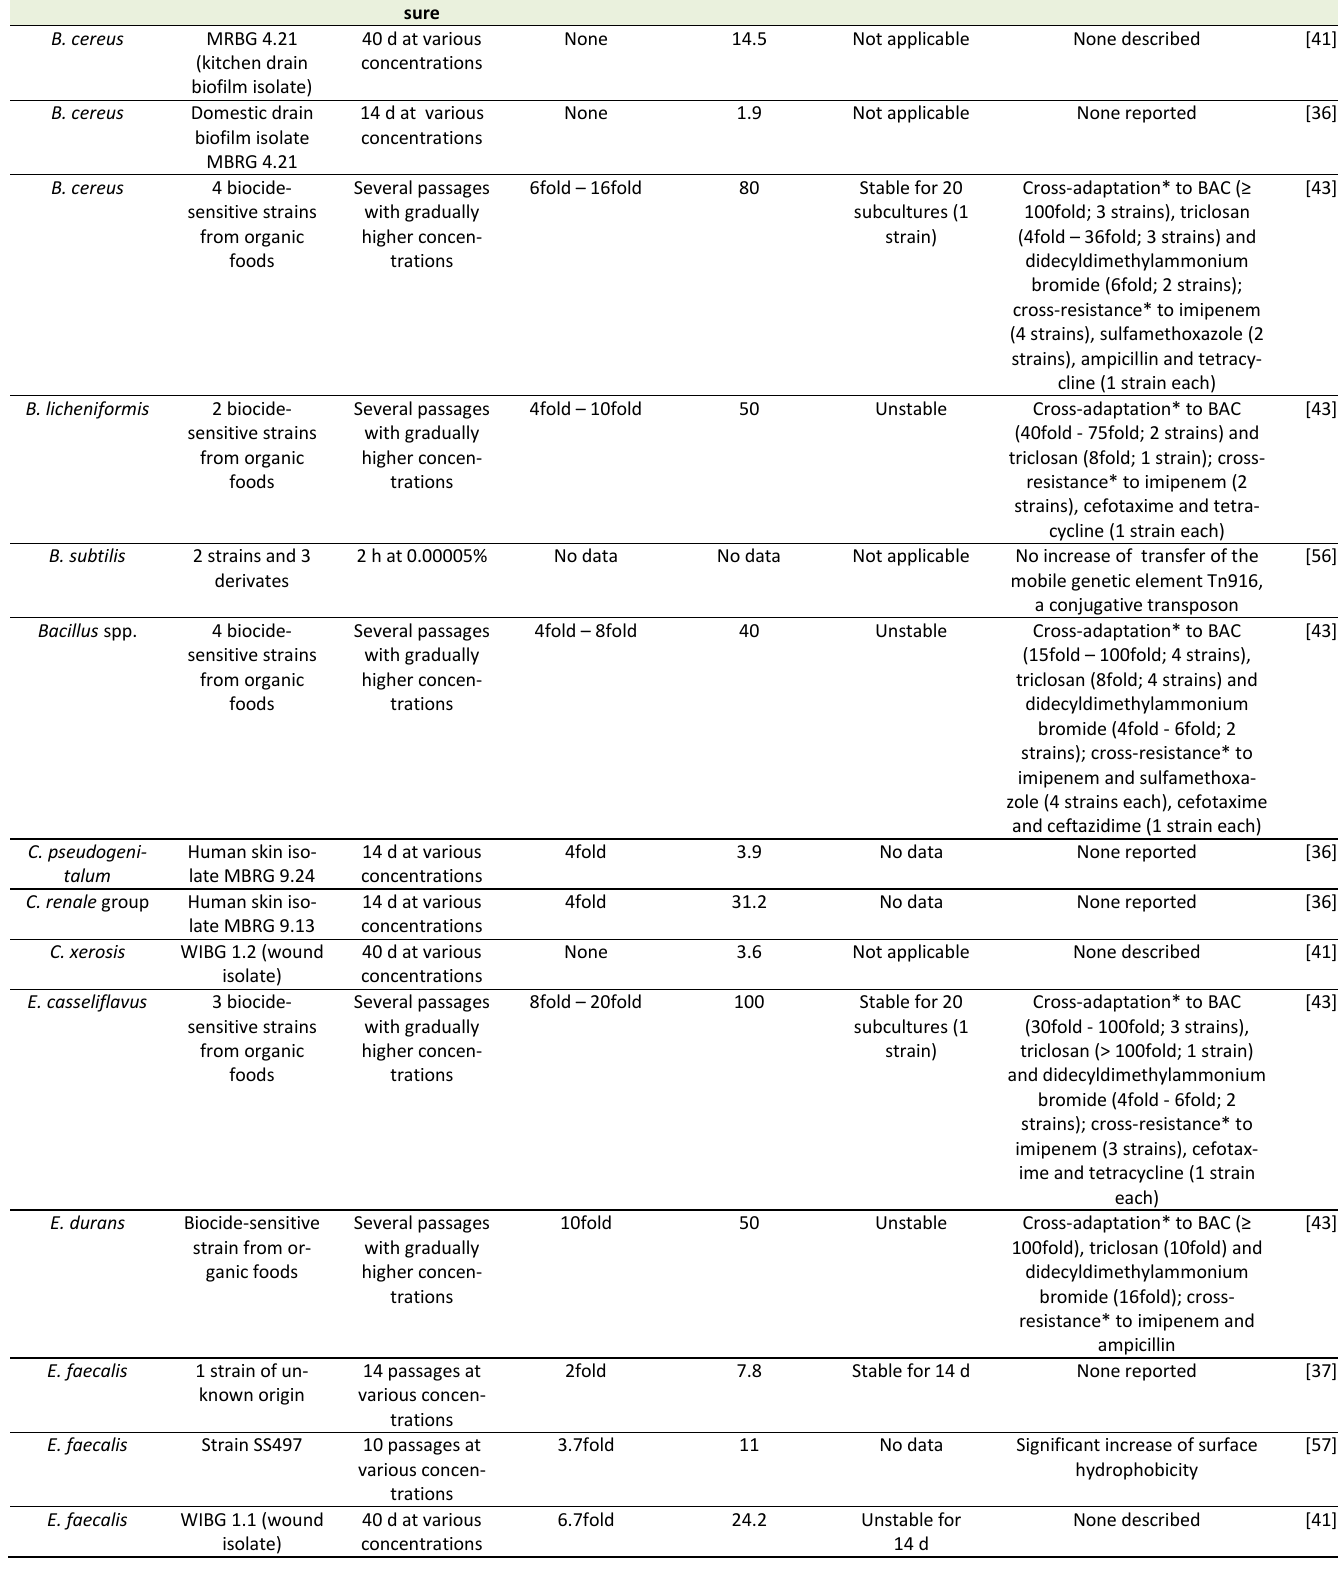
TABLE 2: Adaptive response of Gram-positive bacterial species to sublethal CHG exposure, adapted from [35].